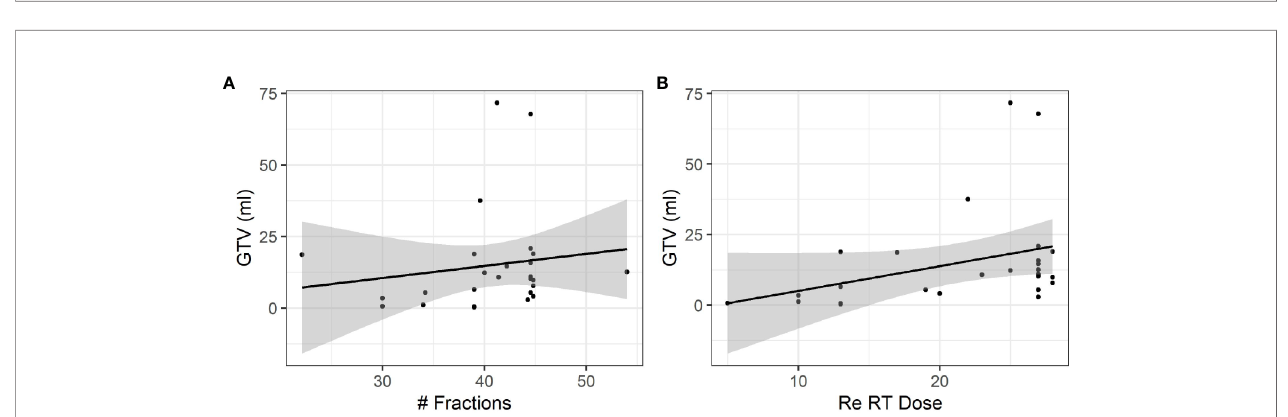
FIGURE 3 | In fl uence of the size of relapsing GBM on fractionation and total dose. (A) A moderate positive association was observed between the size of relapsing GBM and the total number of fractions (r = 0.35). (B) A weak positive association was observed between the size of relapsing GBM and the dose (r =